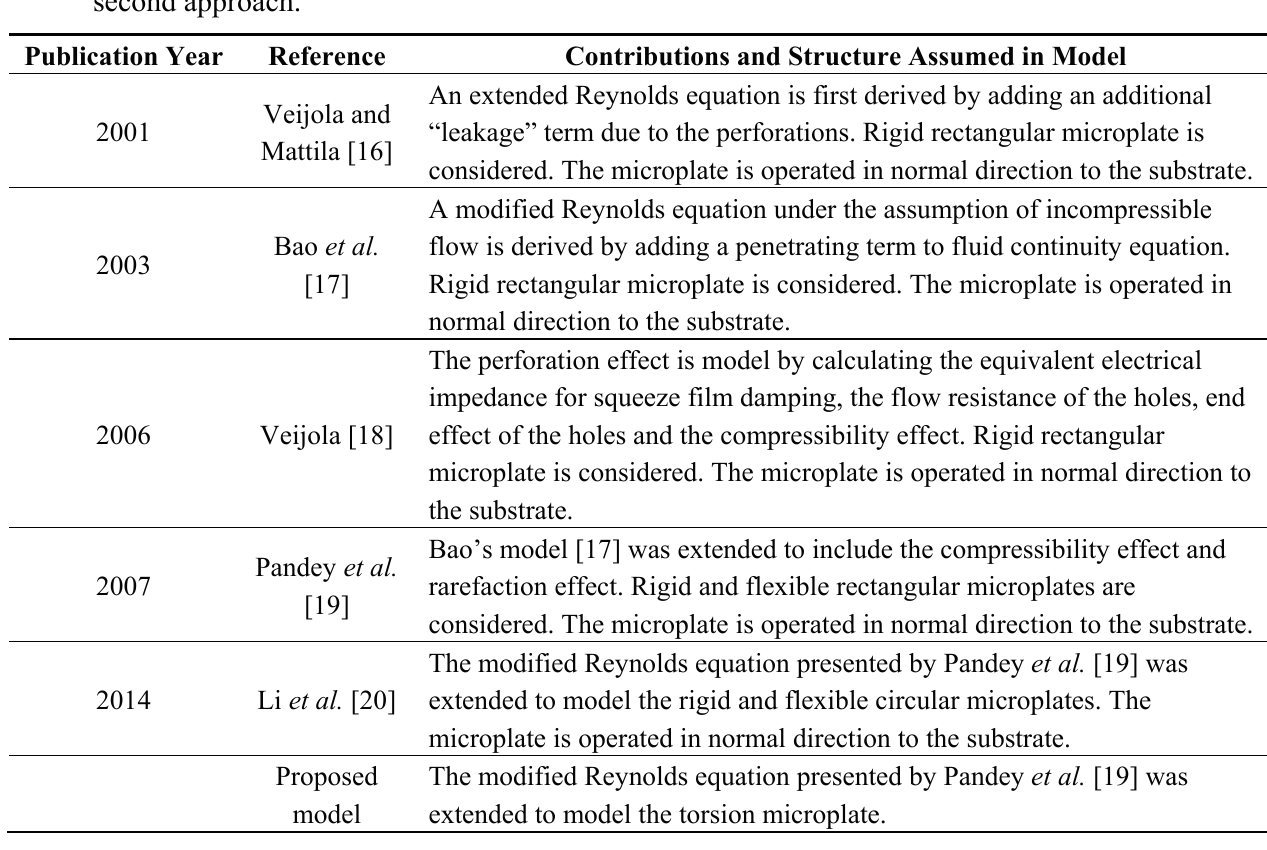
Table 1. Comparison of the previous models and the proposed model based on the second